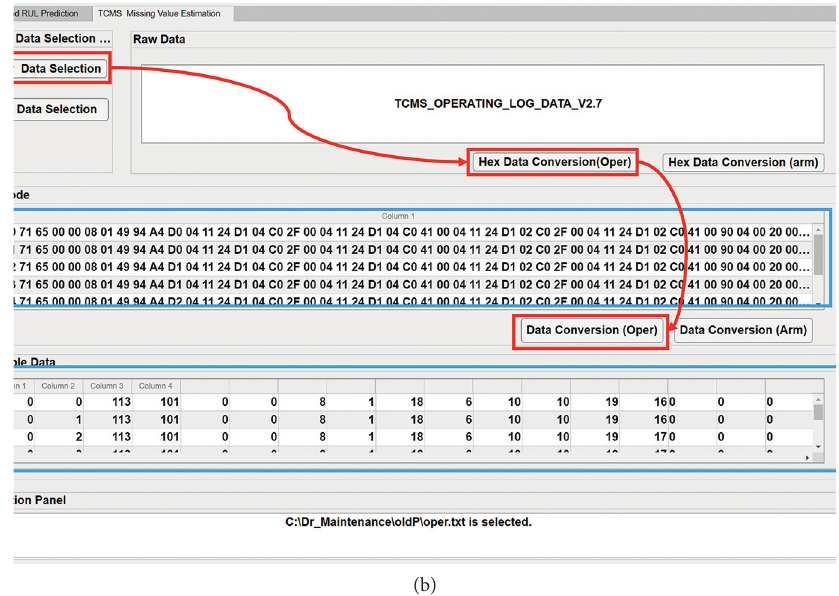
Figure 2: Encrypted TCMS data sample and the developed conversion tool. (a) A TCMS data sample and its encrypted texts. (b) The decryption and conversion software program developed in this